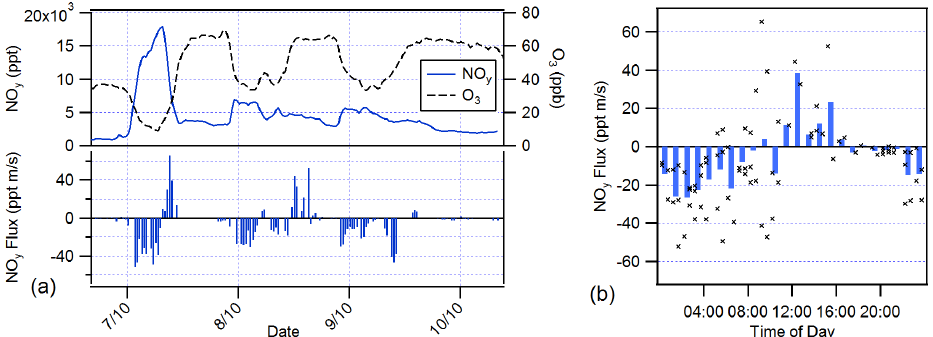
Fig. 8. (a) Mixing ratio and flux observations, and (b) diurnal average during the high-pollution event from 7 to 9 October 2011 at HFWR.